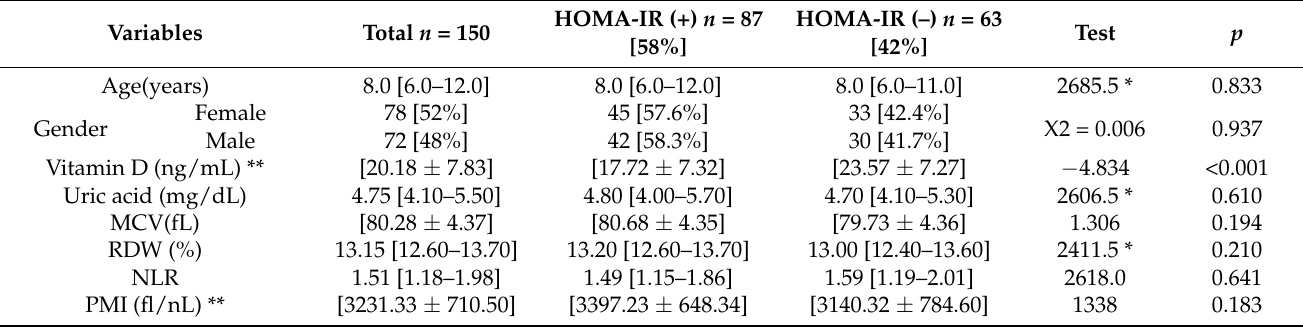
Table 1. Sociodemographic and biochemical characteristics of the two samples.